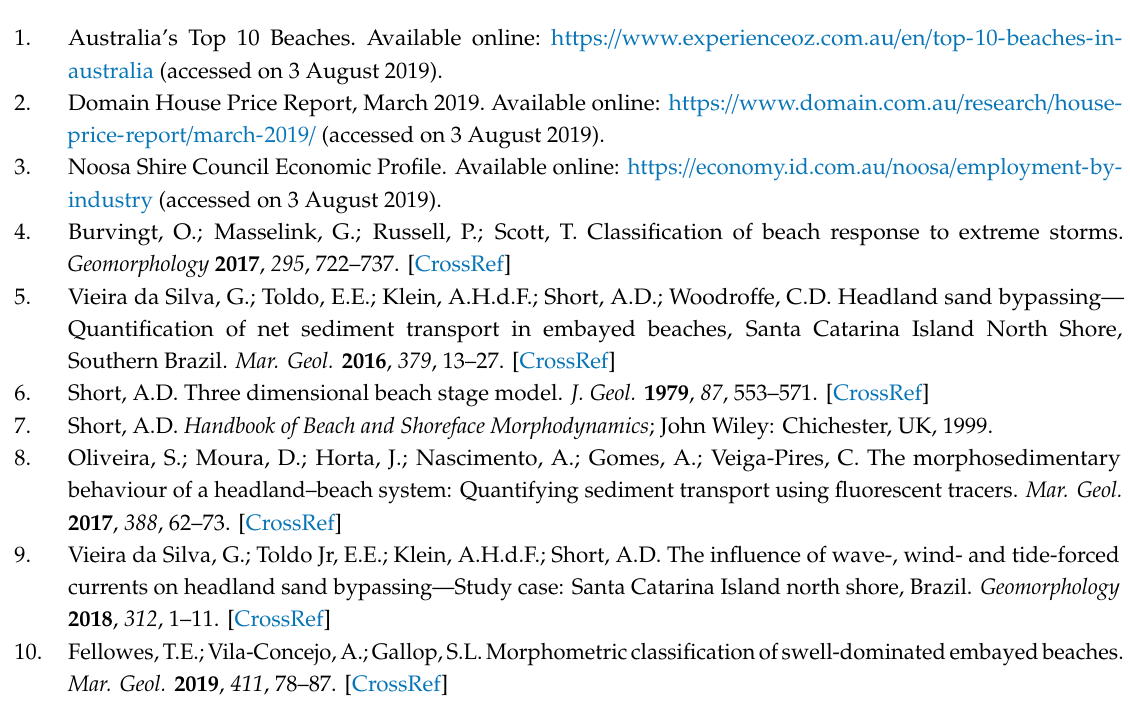
Figure S1: Camera locations and image overlap, Figure S2: Image residuals for FC6310R (8.8 mm), Figure S3: Camera locations and error estimates, Figure S4: Camera orientations and error estimates, Figure S5: GCP locations and error estimates, Figure S6: Reconstructed digital elevation model. Table S1: Cameras, Table S2: Calibration coe ffi cients and correlation matrix, Table S3: Average camera location error, Table S4: Average camera rotation error, Table S5: Control points RMSE, Table S6: Control